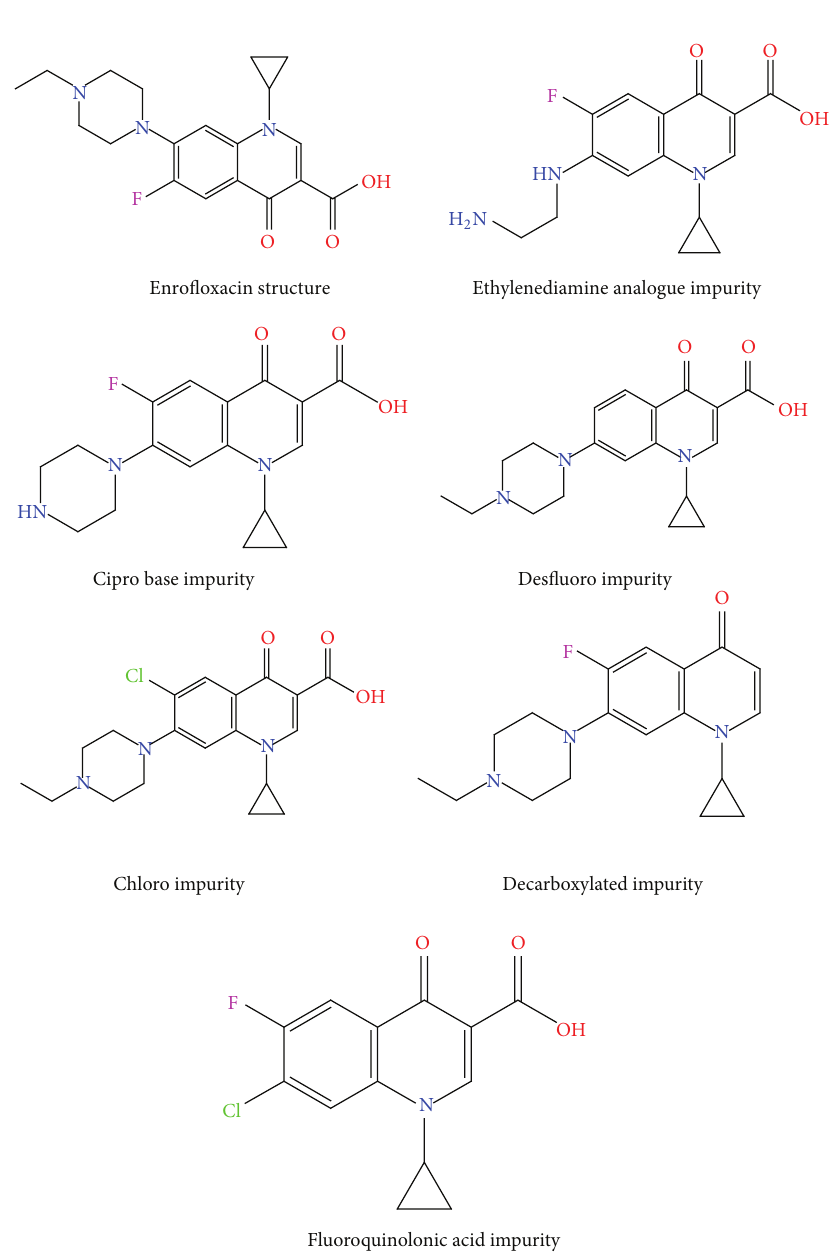
Figure 1: Structures of EFX and its related impurities.